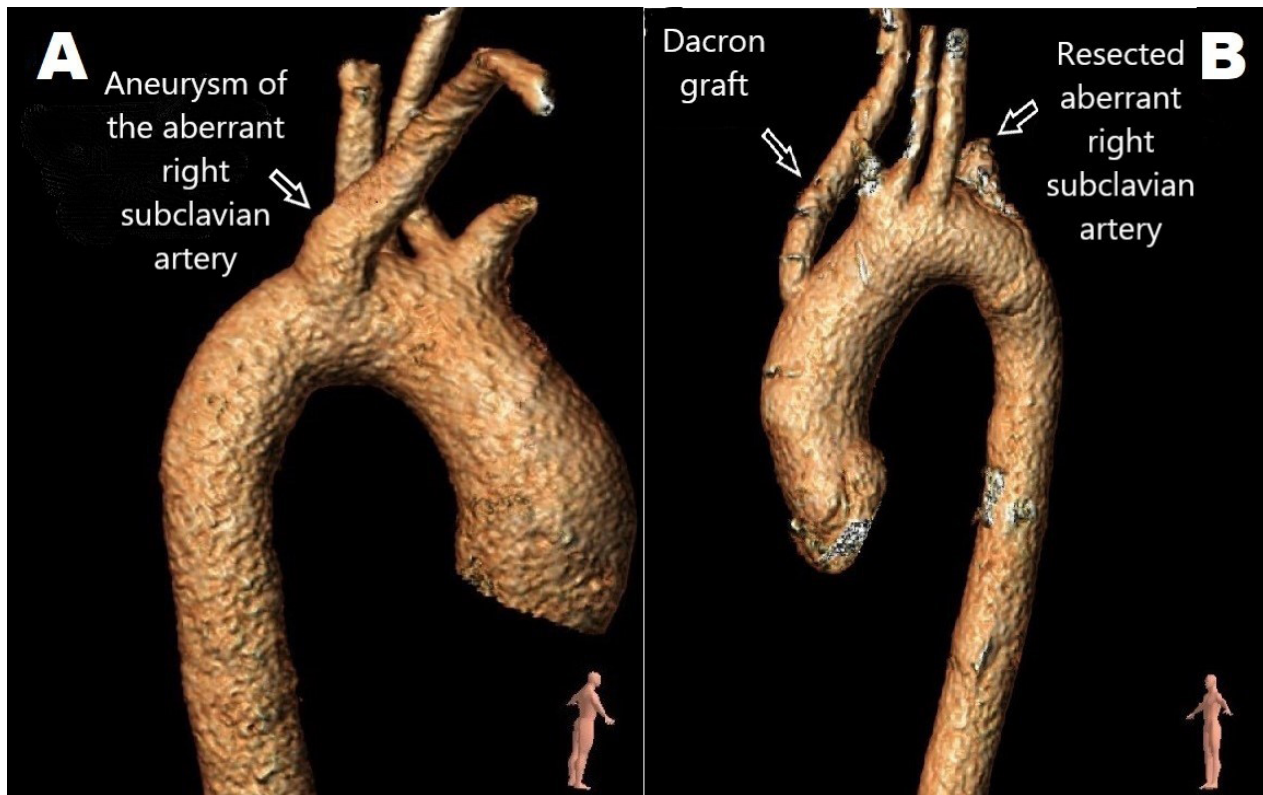
Fig. 3 - Preoperative (A) and postoperative (B) control three-dimensional reconstructed computed tomography angiography of open aberrant right subclavian artery resection/ligation and ascending aorta-right subclavian artery